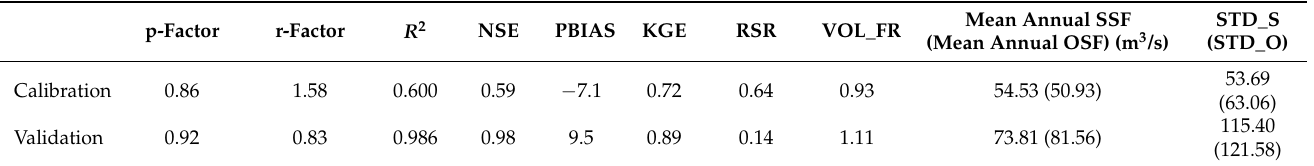
Table 3. Summary of the performance evaluation metrics’ statistics during calibration and